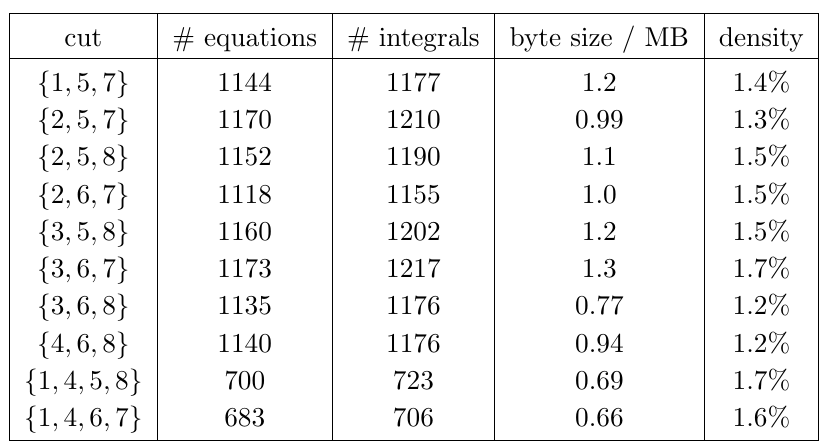
Table 4 . Linear systems of IBP identities on the 10 cuts given in eq. (5.4) for reducing the target hexagon-box integrals in eq. (5.8). The storage size is for the corresponding matrix and is measured in megabytes. The density refers to the percentage of non-vanishing elements in the matrices of these linear